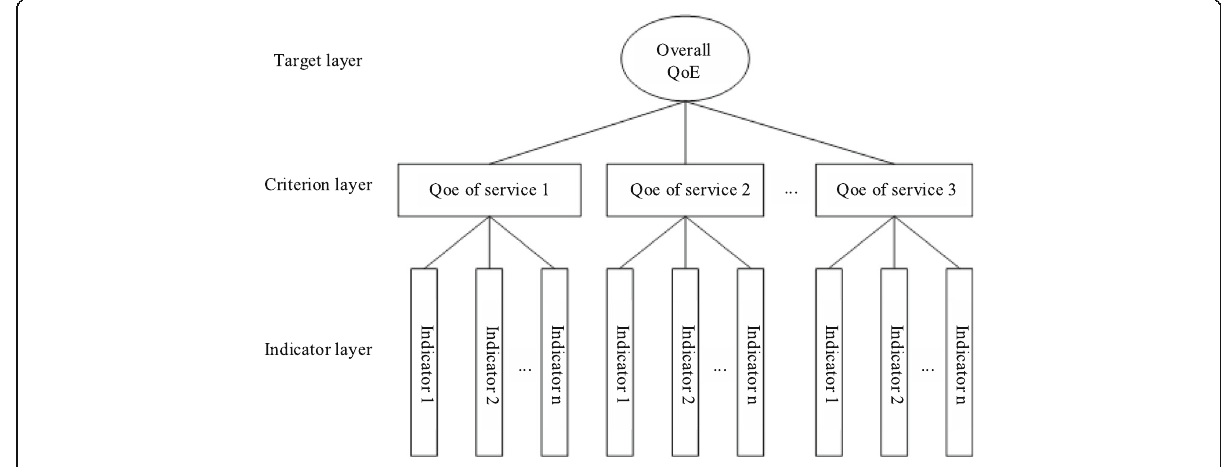
Fig. 3 QoE assessment model for multi-service scenarios